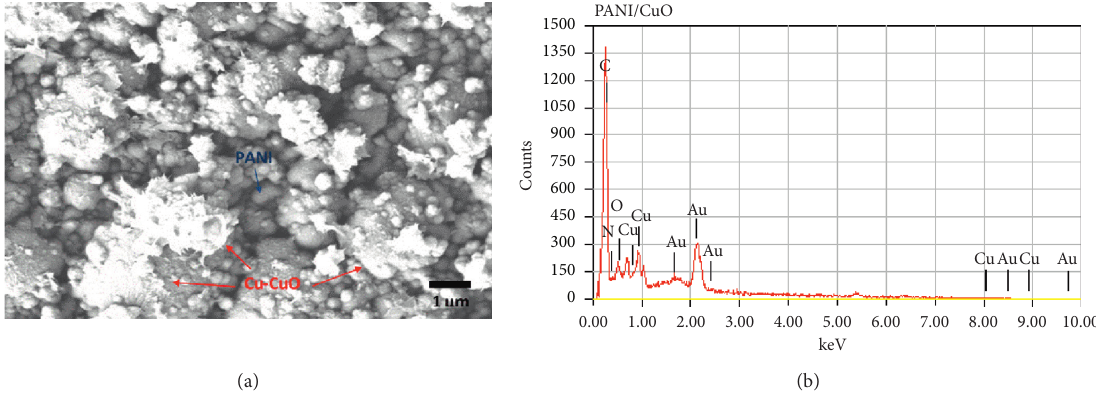
Figure 5: SEM images (a) and EDX (b) of the Cu-CuO/PANI/316L